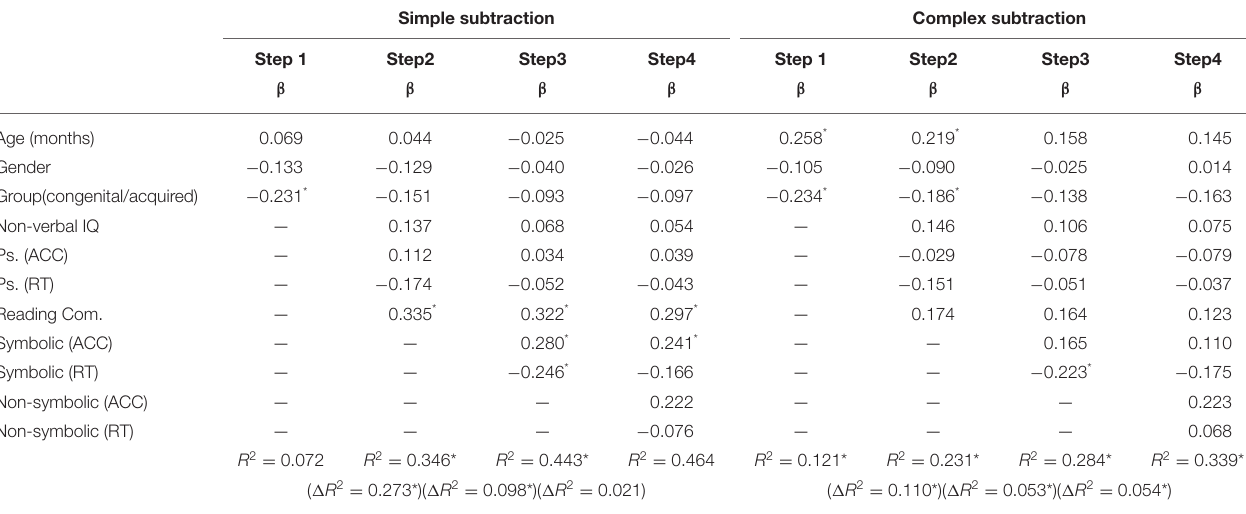
TABLE 6 | Hierarchical regression models predicting arithmetic ability (simple and complex subtraction) from age, gender, group, general cognitive ability, symbolic, and non-symbolic magnitude